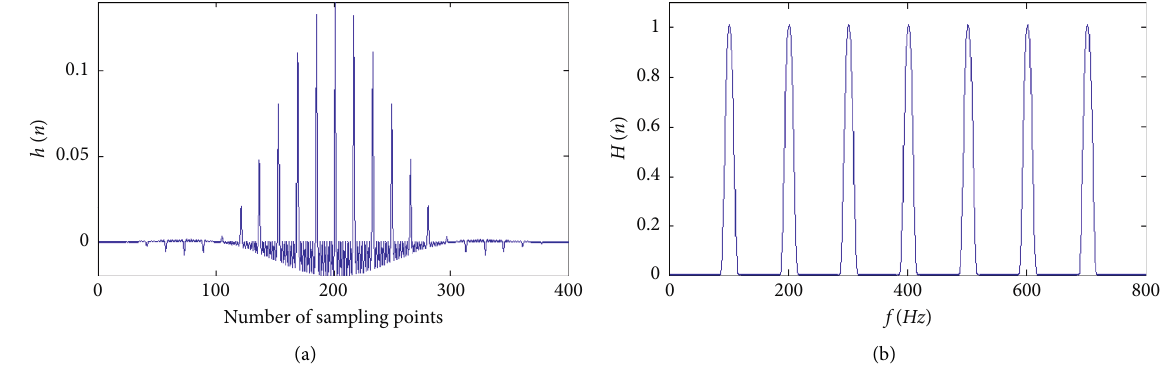
Figure 12: Response curve of multiband filter. (a) Impact response and (b) frequency characteristic.